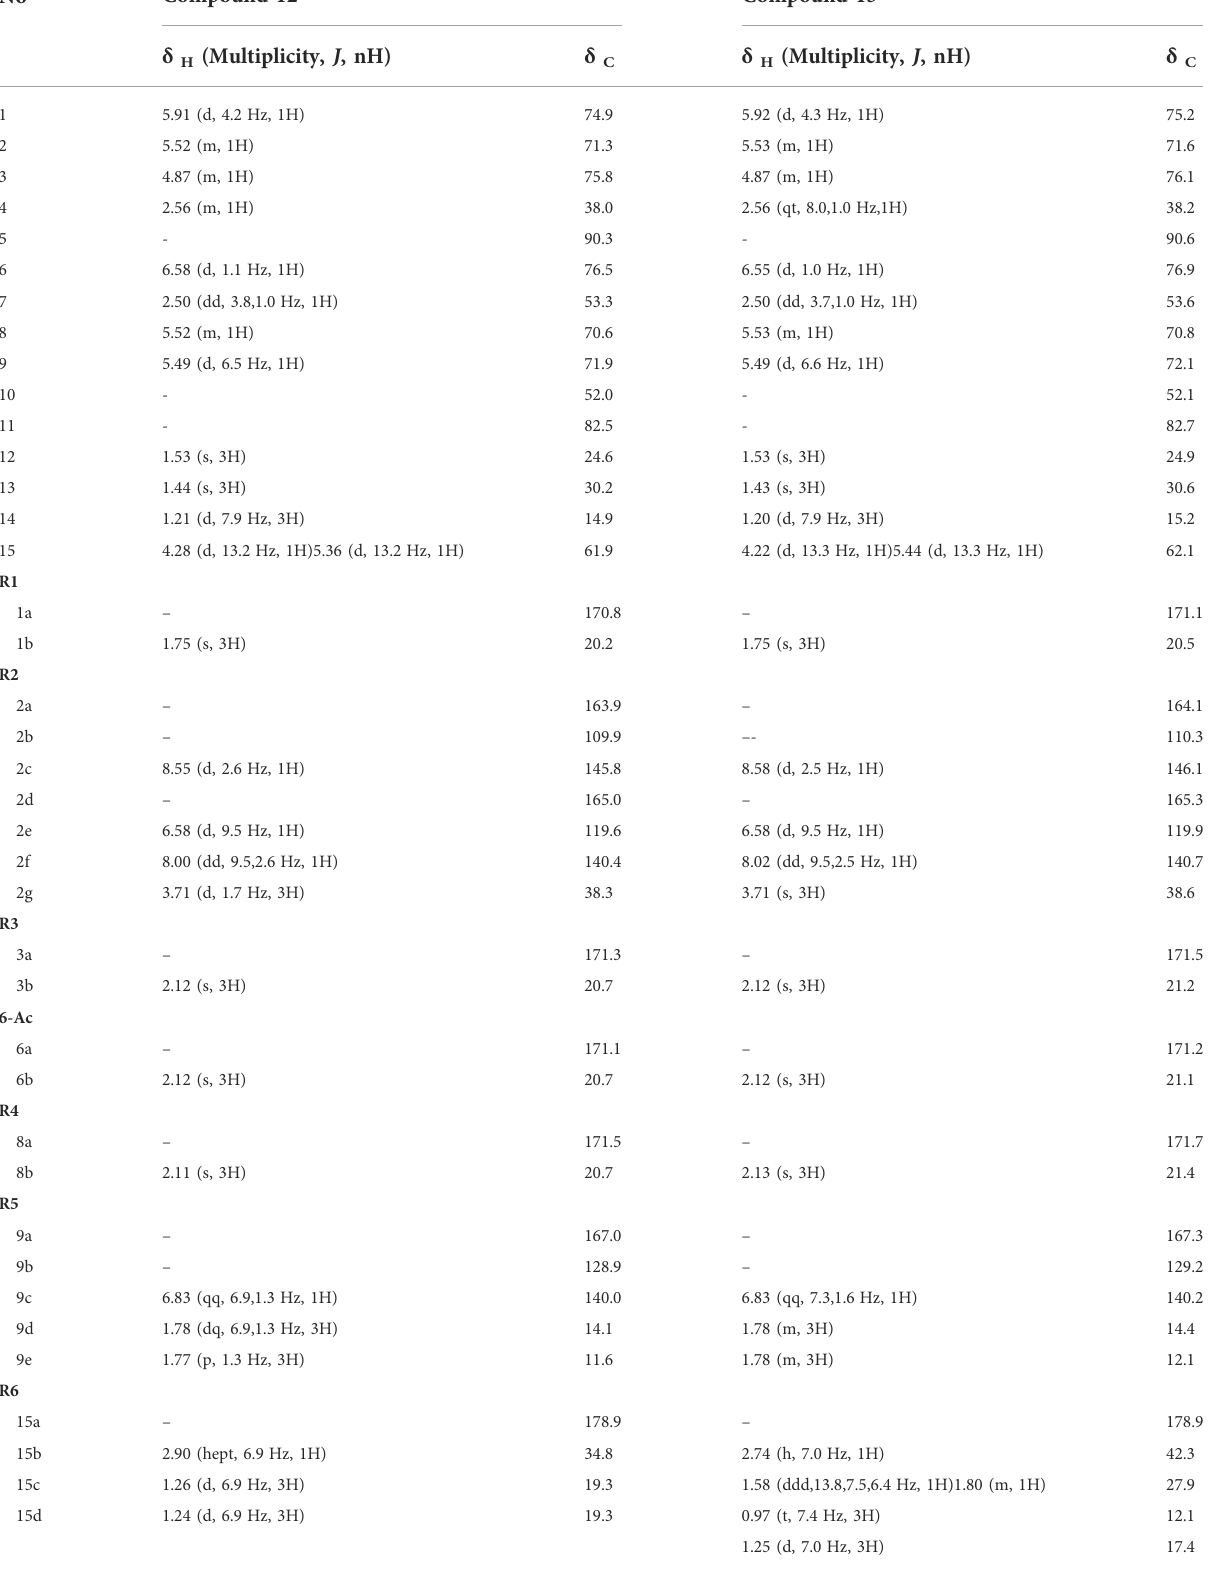
TABLE 5 1 H and 13 C NMR spectroscopic data for compounds 12 – 13 ( δ in ppm, J in Hz). Compound 12 Compound